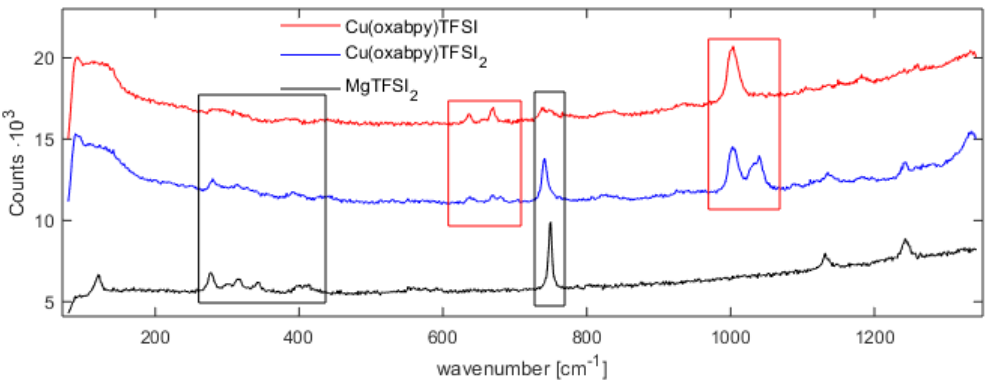
Figure 3. Raman spectra of Cu(oxabpy)TFSI, Cu(oxabpy)TFSI 2 and MgTFSI 2 . For clarity, the Cu I and Cu II spectra were offset by 8 × 10 3 and 11 × 10 3 counts, respectively. Black boxes highlight Raman modes of the TFSI counterion, red dashed boxes mark modes of the complex.